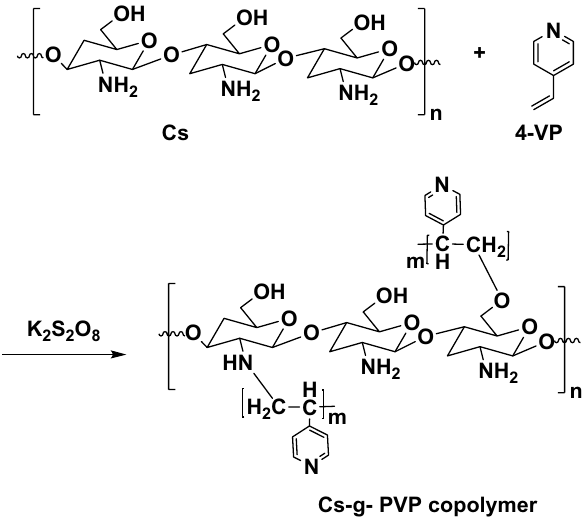
Figure 1. Preparation of graft copolymerization of chitosan and 4-vinylpyridine